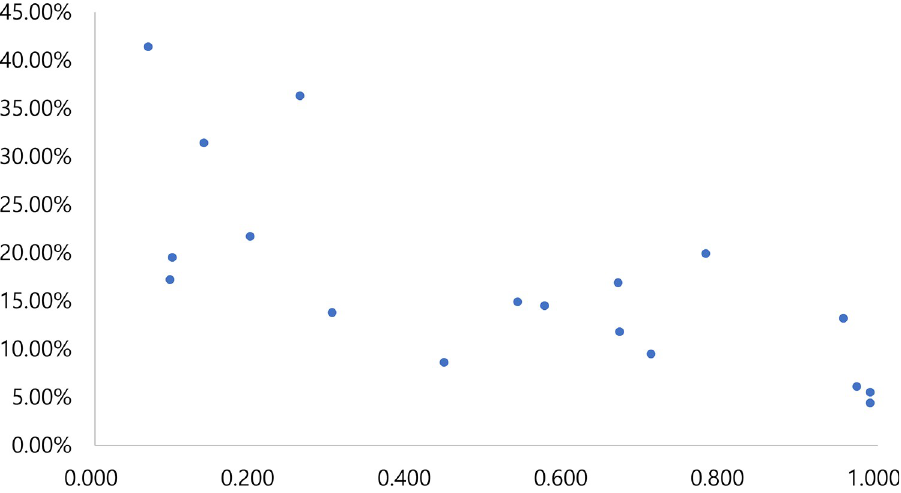
Fig 5. Correlation between Theil T index and coverage of an improved household latrine (x-axis: Theil T index; y-axis: Coverage, the authors generated the map).